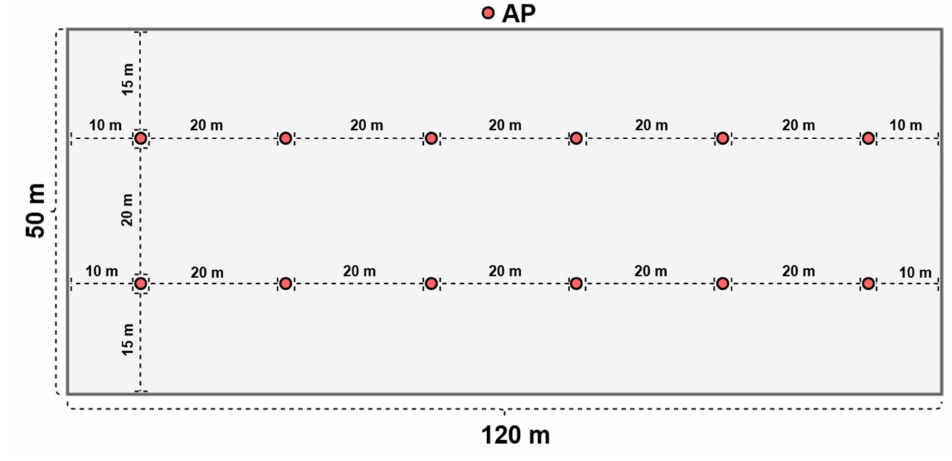
Figure 3. Indoor office scenario